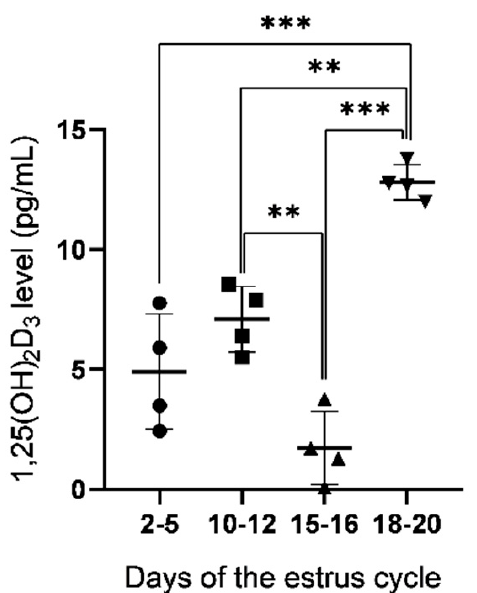
Figure 1. The concentration of 1,25(OH) 2 D 3 (mean ± SD) in uterine flushings obtained from pigs on days 2–5, 10–12, 15–16 and 18–20 of the estrous cycle. ** p < 0.01; *** p < 0.001 (one-way ANOVA followed by Tukey post hoc test). n = 4 per each group.